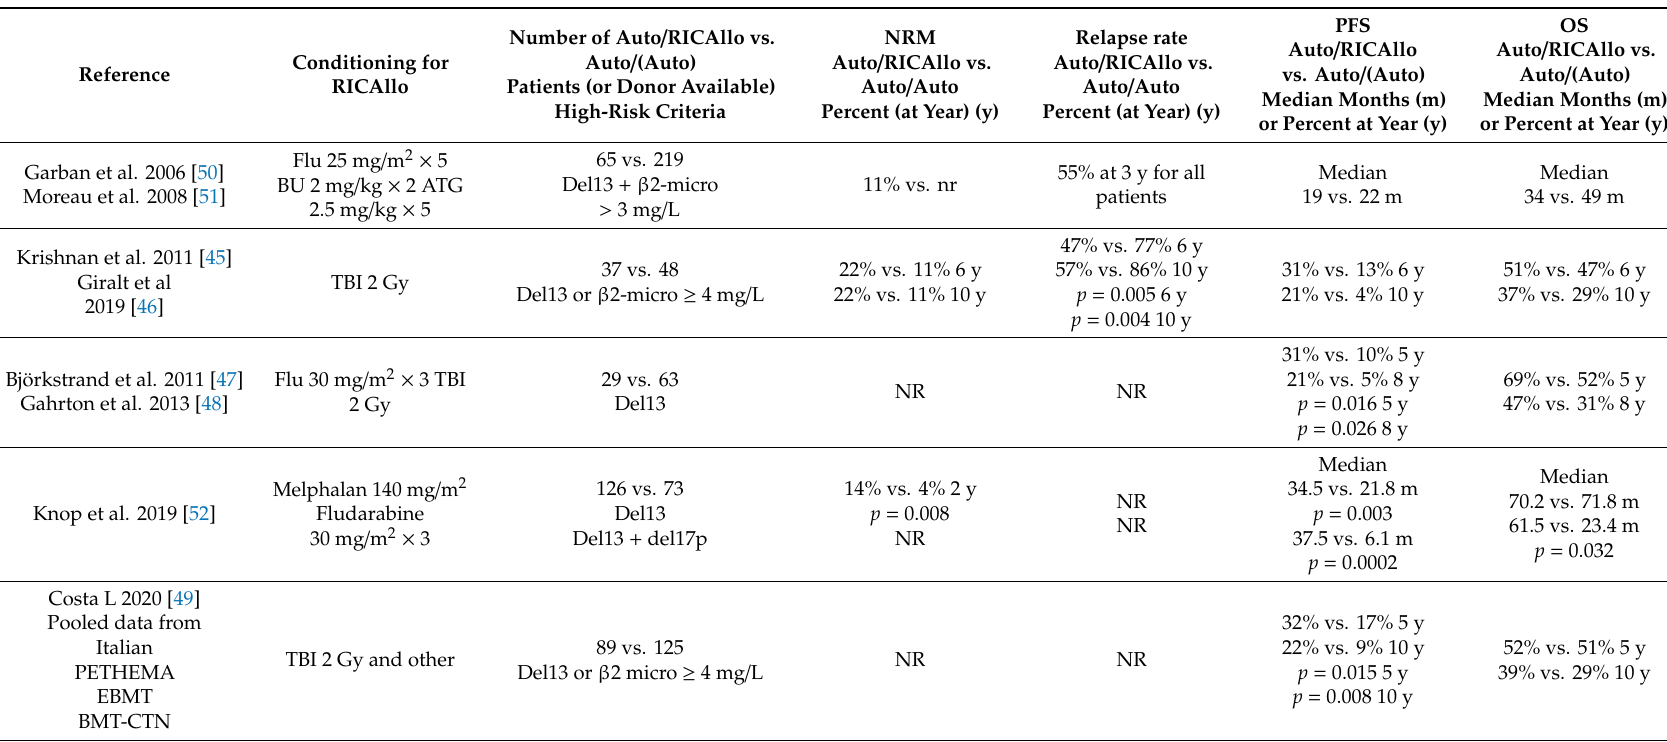
Table 2. Prospective studies comparing autologous (Auto) combined with reduced-intensity conditioning (RIC) allogeneic transplantation (Auto / RICAllo) to single Auto or tandem Auto (Auto / Auto) in upfront-treated high-risk MM